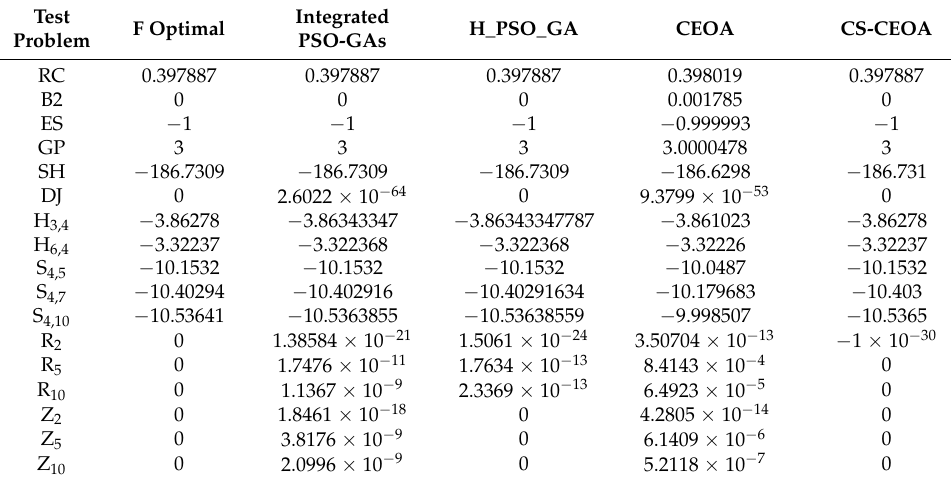
Table 2. Calculated solution versus Global optimal